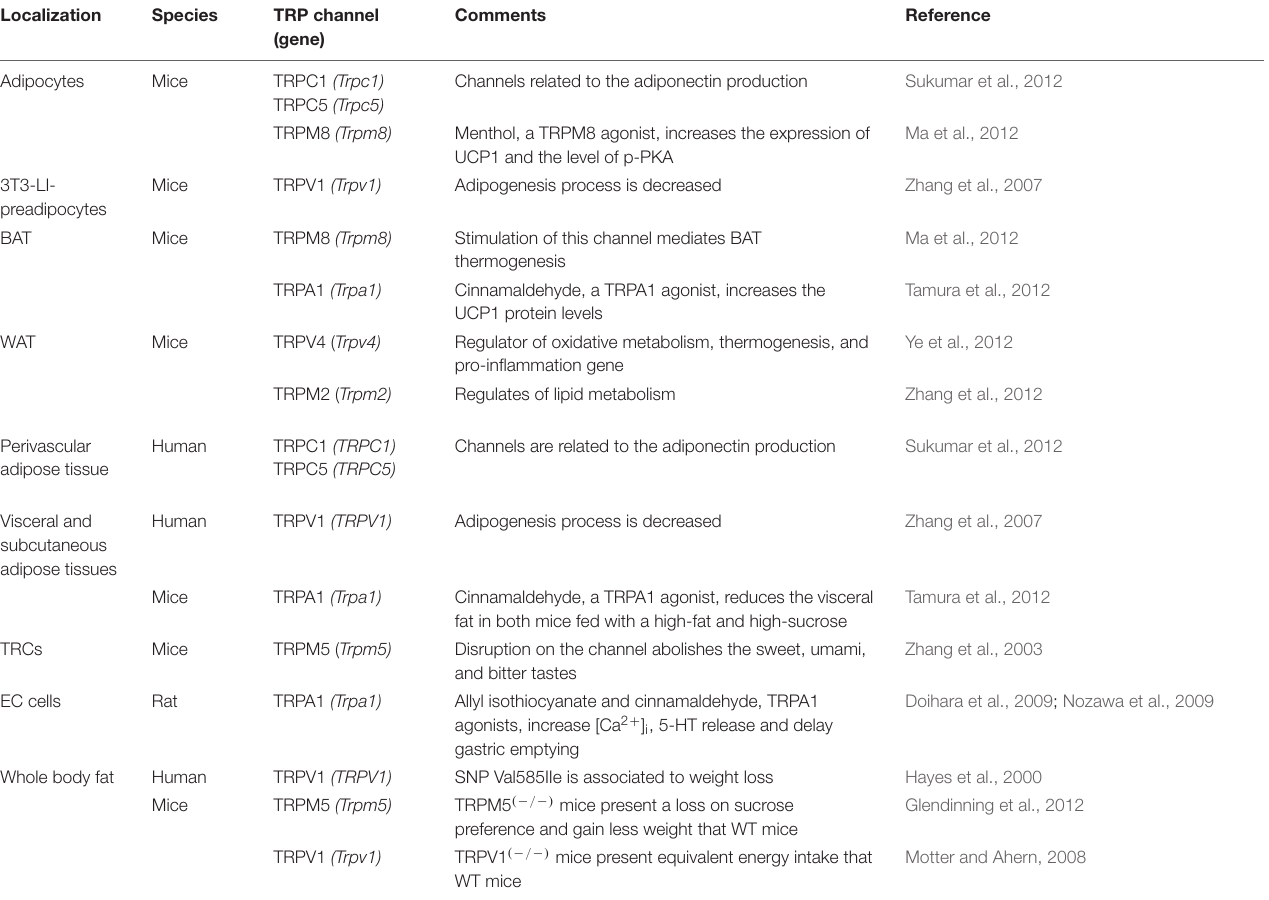
TABLE 2 | Characterization of TRPs associated to